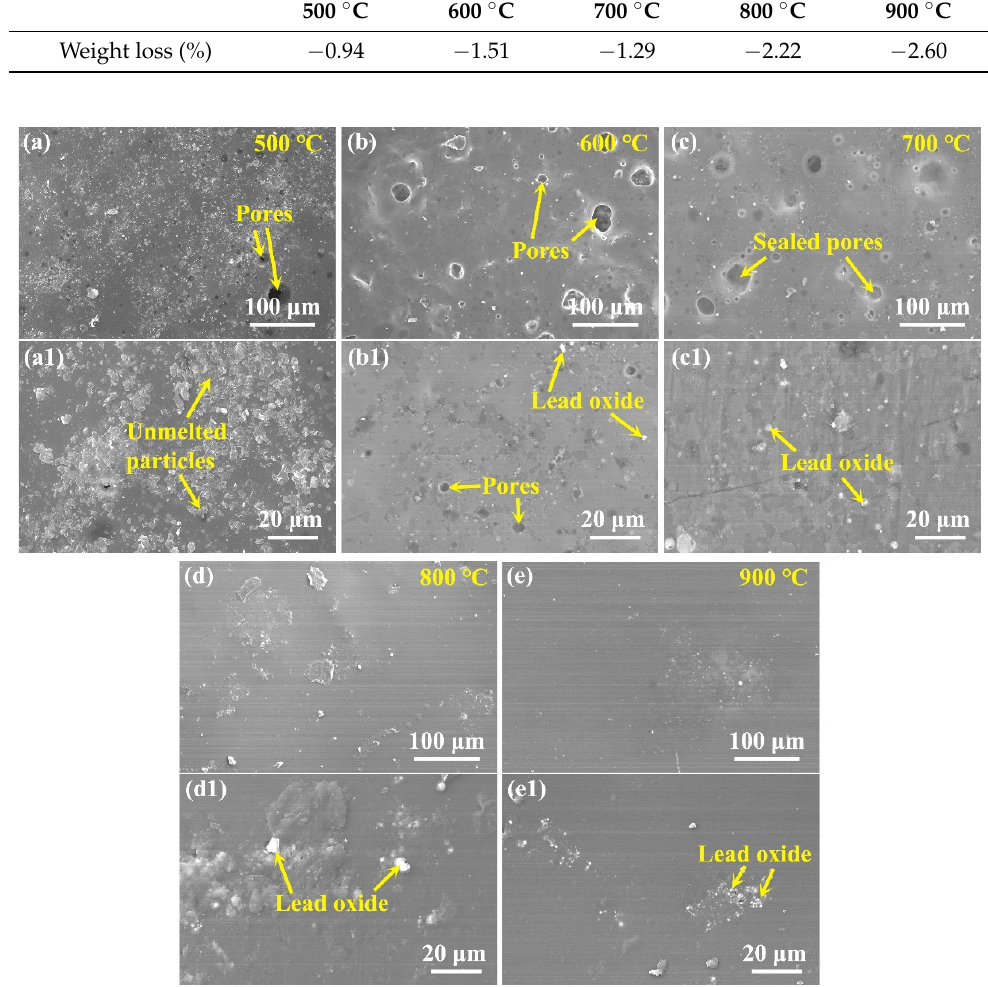
Table 2. Weight loss of the Pb20 samples after being oxidized at different temperatures for 2 h.